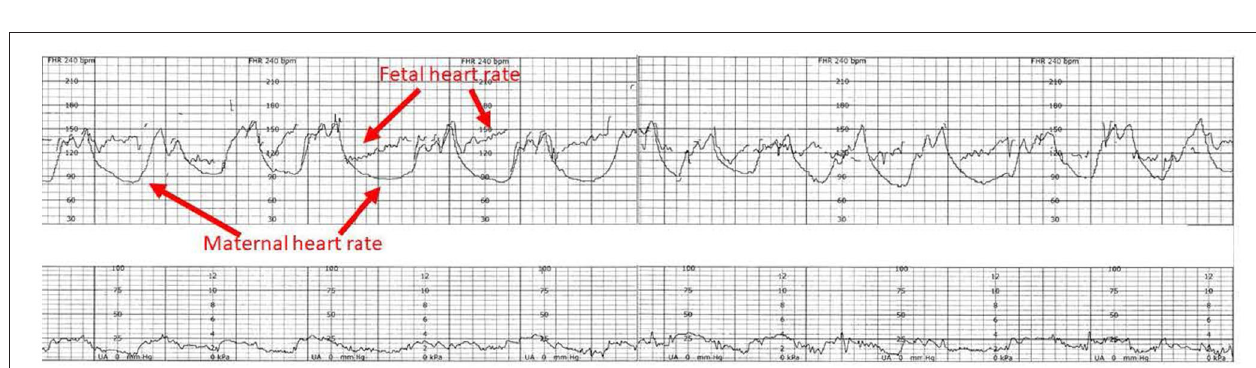
FIGURE 11 | The heart rate tracing demonstrates the characteristic amplitude, height and timing of maternal accelerations associated with maternal pushing, especially when the tracing is continuous. The potential for inadvertently recording the MHR during labor has been known since the introduction of EFM. The problem is facilitated by the elevated maternal baseline, more likely in the 2nd stage of labor. The appearance of accelerations with bearing down efforts. The obstetrical care provider must recognize the potential for misinterpreting the maternal heart rate for the fetal heat rate and resolve any uncertainty. Applying the maternal transducer or have the mother cease pushing will often help resolve the issue. The application of a scalp electrode is usually definitive. Scaling − 30 bpm/cm—vertical, 3 cm/min—horizontal—each panel is 16min wide. *Tracings reprinted from Schifrin (122) (with permission from the publisher). **Tracings reprinted from Schifrin (123) (with permission from the